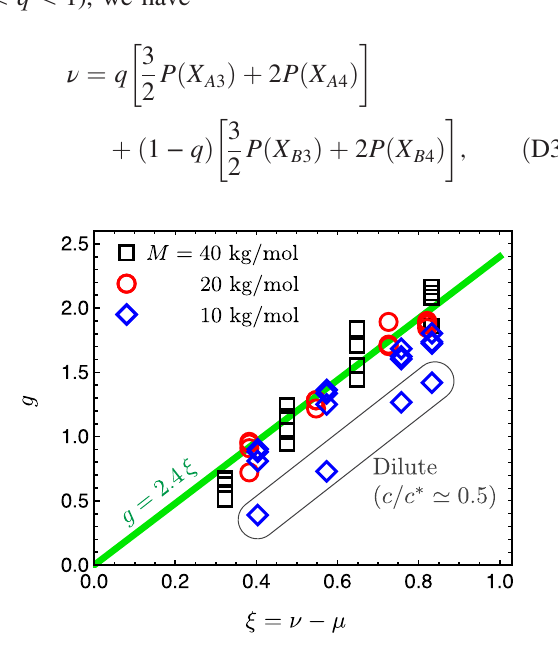
FIG. 8. Comparison between the experimentally obtained g ¼ g ð p; c=c (cid:3) Þ [defined in Eq. (12)] and the dimensionless structure parameter ξ ¼ ν − μ . Here, ν and μ are the numbers per precursor of elastically effective chains and cross-links, respectively. We calculate ν , μ , and ξ using the Bethe approxi- mation with p estimated from Eq. (A1). We determine g from the data in Fig. 5(a) with Eq. (12). Each symbol represents one sample that is characterized by the molar mass M , concentration c , and connectivity p . The blue diamonds, red circles, and black squares represent M ¼ 10 , 20, and 40 kg = mol, respectively. The green line represents g ¼ 2 . 4 ξ . The four blue diamonds enclosed by the gray curve represent the samples with the lowest normalized polymer concentrations ( c=c (cid:3) ≃ 0 . 5 ) in this experi- ment. They deviate from the green line because they have many elastically ineffective connections such as the intramolecular bonds and loops [16,23,24], causing the overestimation of ξ